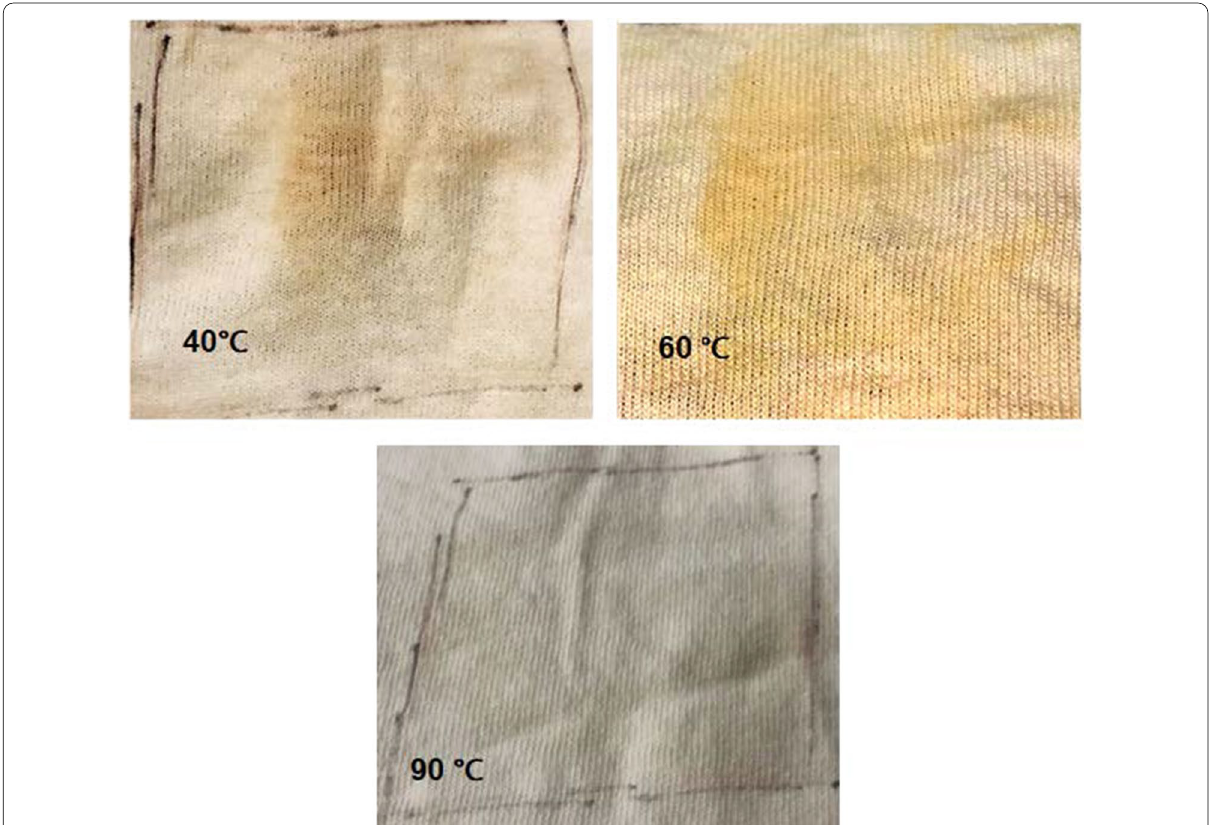
Fig. 1 The original trace of the blood stain after washing the cotton fabrics with blood stains at 40, 60,